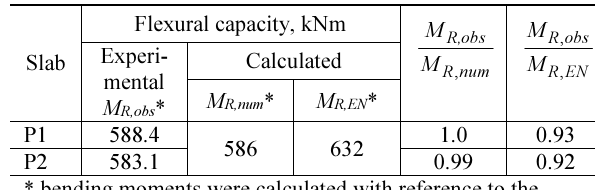
Table 5. Comparison of the results of research on the flexural capacity of the